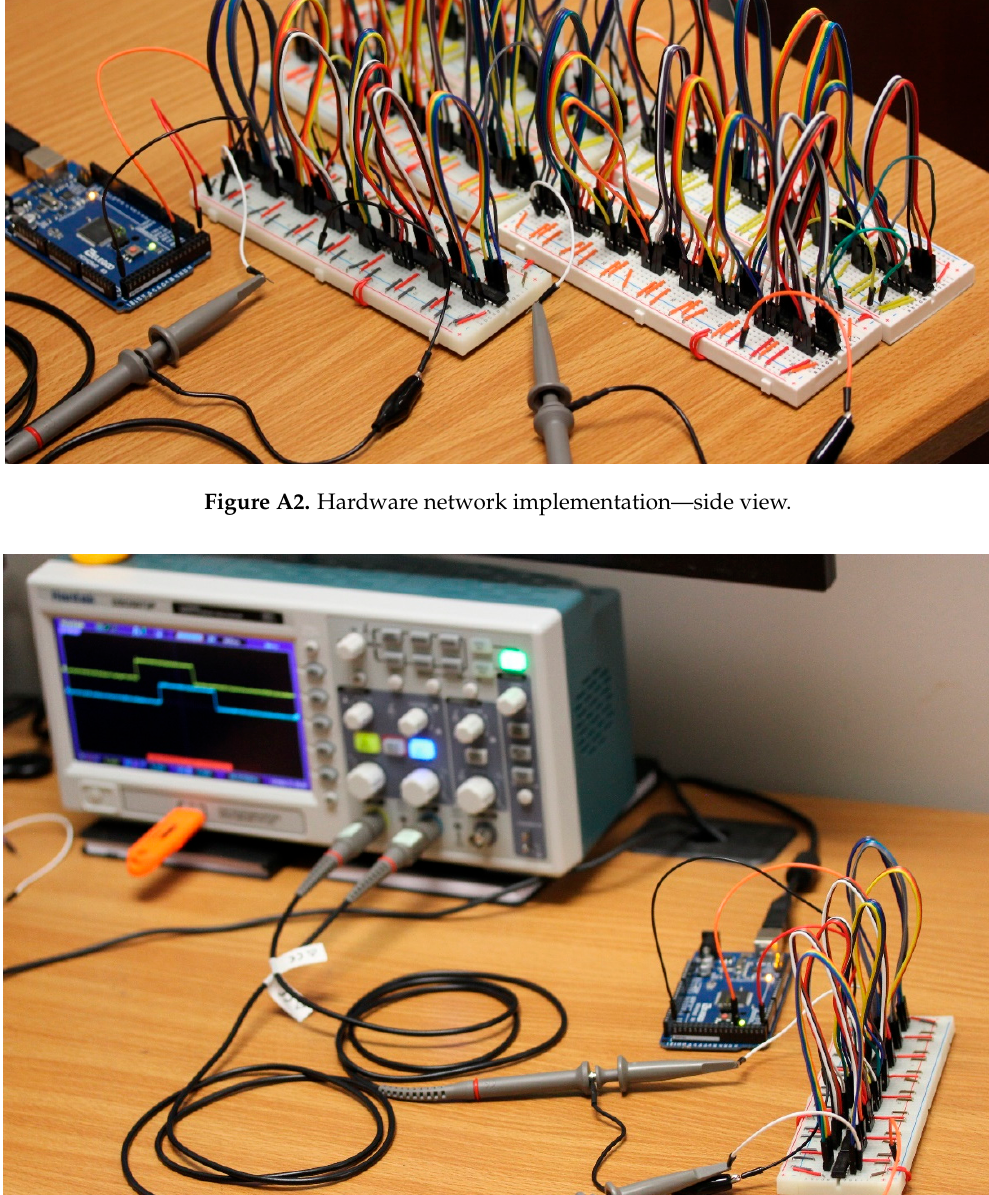
Figure A3. Data collection configuration.